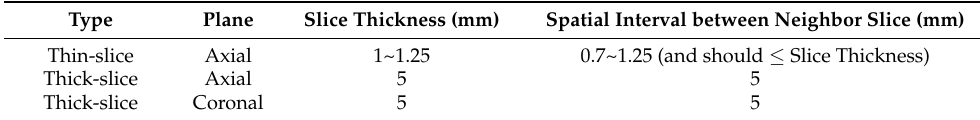
Table 1. Requirements for each DICOM CT set used in our